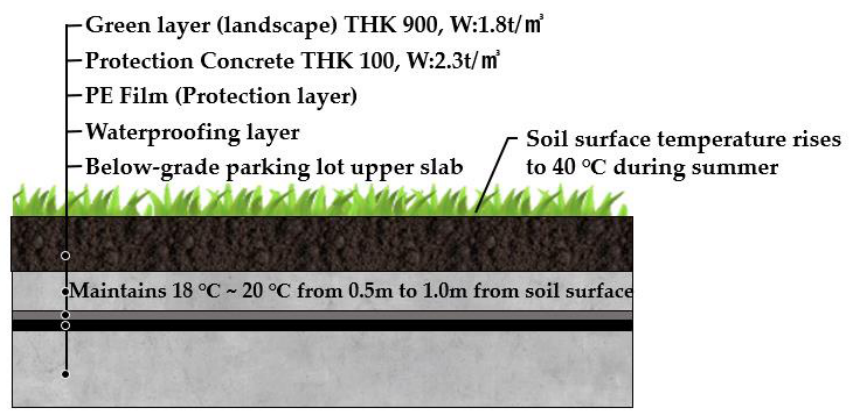
Figure 3. Concrete structure slab layer of ENC-SPRG waterproofing.